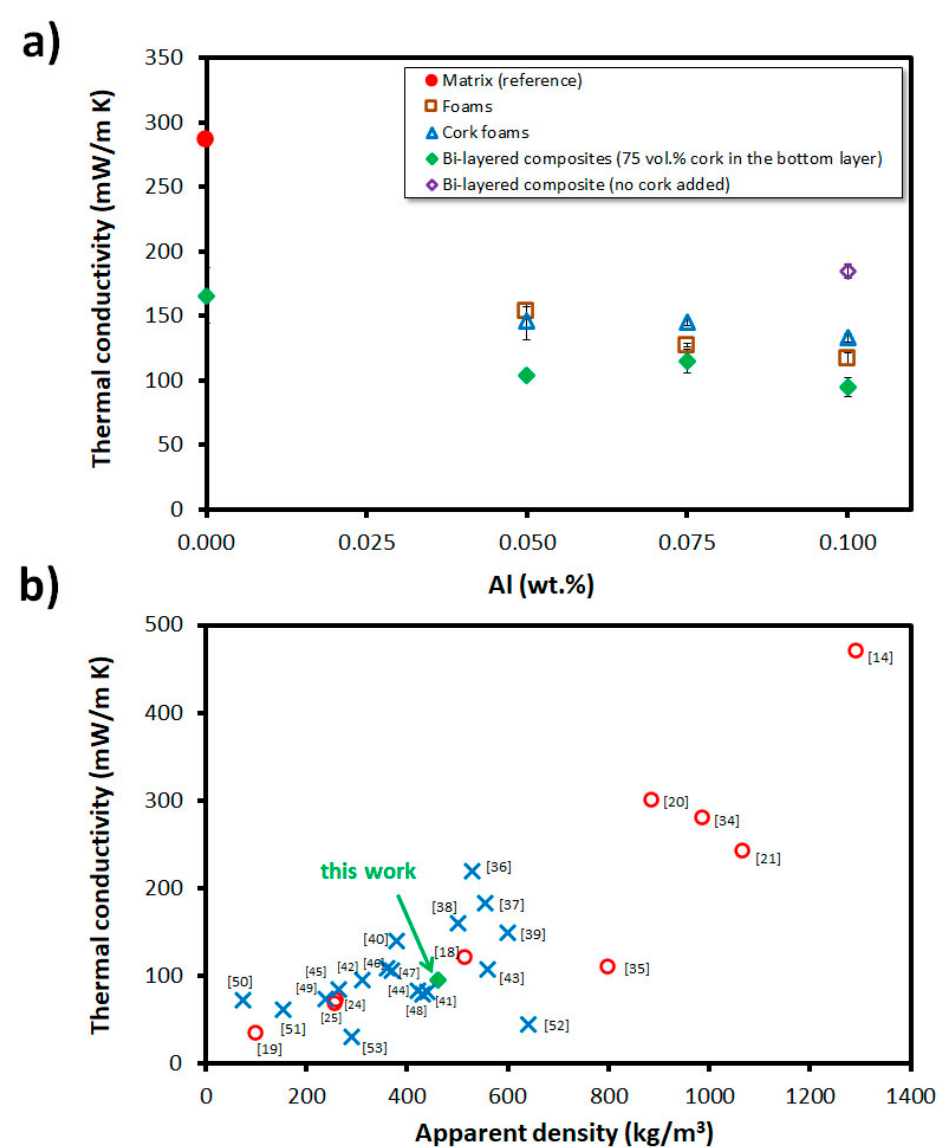
Figure 7. ( a ) Thermal conductivity of the various inorganic polymers produced in this study, and ( b ) comparison between the lowest thermal conductivity value here achieved for the bi-layered composite with literature studies concerning inorganic polymer foams (blue mark) and composites (red circle).